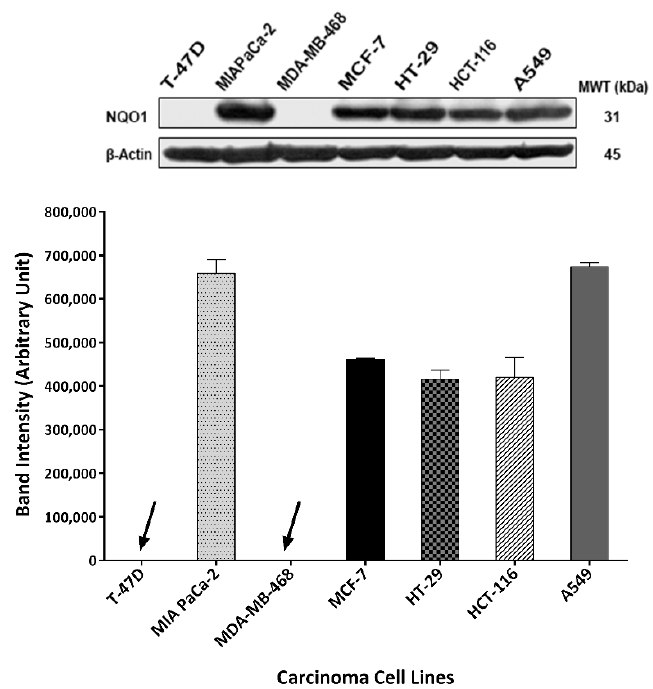
Figure 7. Representative western blot bands and mean ± SD bars showing NQO1 expression and band intensity in untreated A549, HCT-116, HT-29, MCF-7, MDA-MB-468, MIAPaCa-2, T-47D protein lysates. Antibodies to NQO1 and housekeeping gene β-Actin were used. NQO1 expression was seen in tested cell lines except for MDA-MB-468 and T-47D. Arrows show no detectable NQO1 expression in MDA-MB-468 and T-47D. Assay repeated three times.